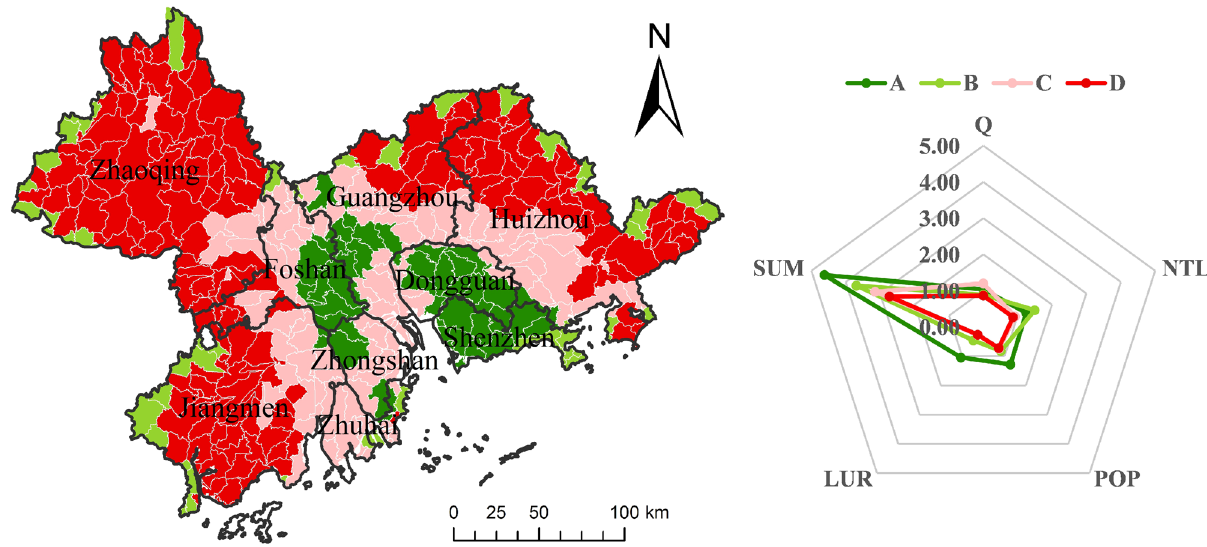
Figure 10. Regional distribution and characteristics of urban habitat coupling degree from 1990 to 2018. Q, habitat quality index; NTL, nighttime light; POP, proportion of population; LUR, land urbanization rate; SUM, the SUM of the average values of the four indicators (standardized) in each